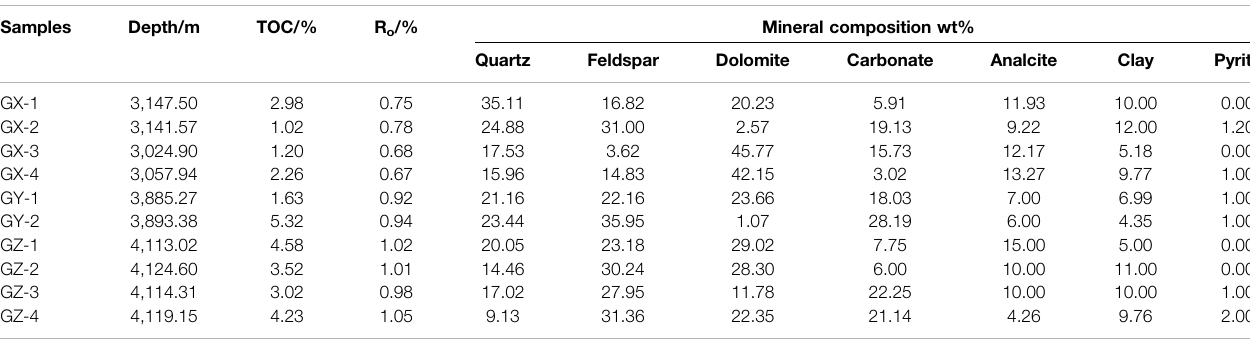
TABLE 1 | Mineral composition and organic geochemistry for all shale samples. Samples